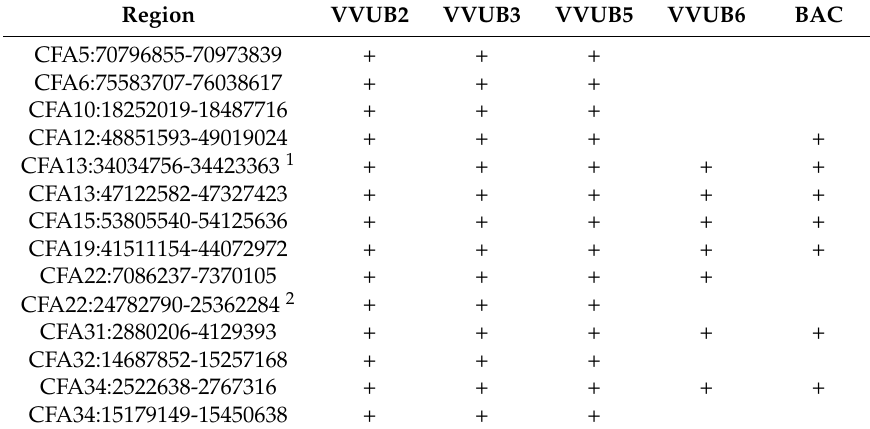
Table 1. Genomic regions identified in red fox ( Vulpes vulpes L., VVU) B chromosomes (Bs). Region coordinates are given according to the dog (CanFam3.1, CFA) genome assembly. VVUB2—flow sorted B sample, VVUB3, 5 and 6—three Bs microdissected from a single metaphase plate, BAC—bacterial artificial chromosome (BAC) clone mapping data from Reference